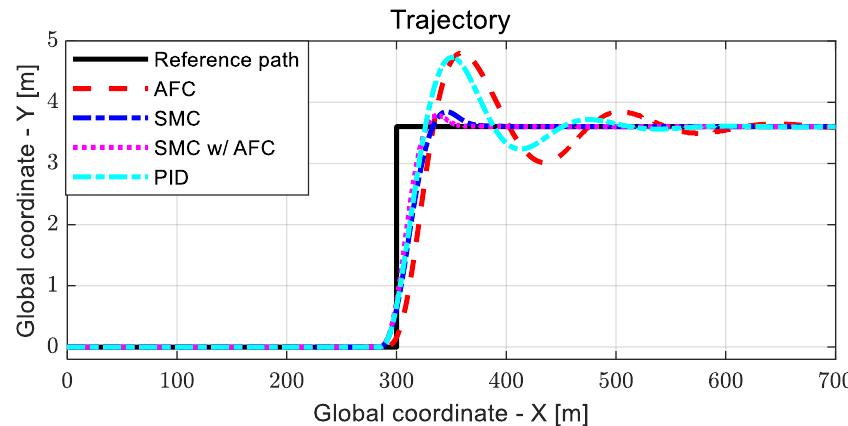
Figure 20. Results: cost value comparison for the lane change.